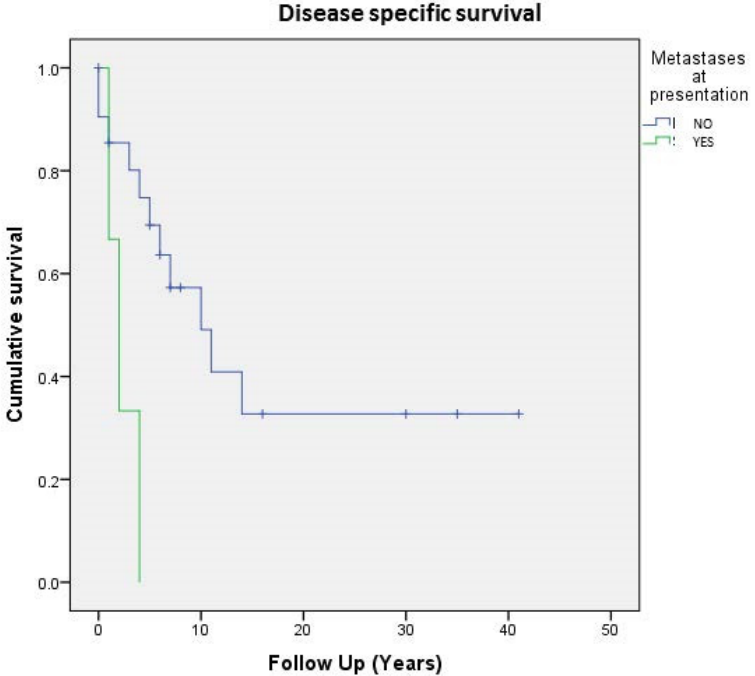
Figure 3. Cumulative survival of 24 patients affected by primary bone solitary fibrous tumor; stratification by metastases at presentation.